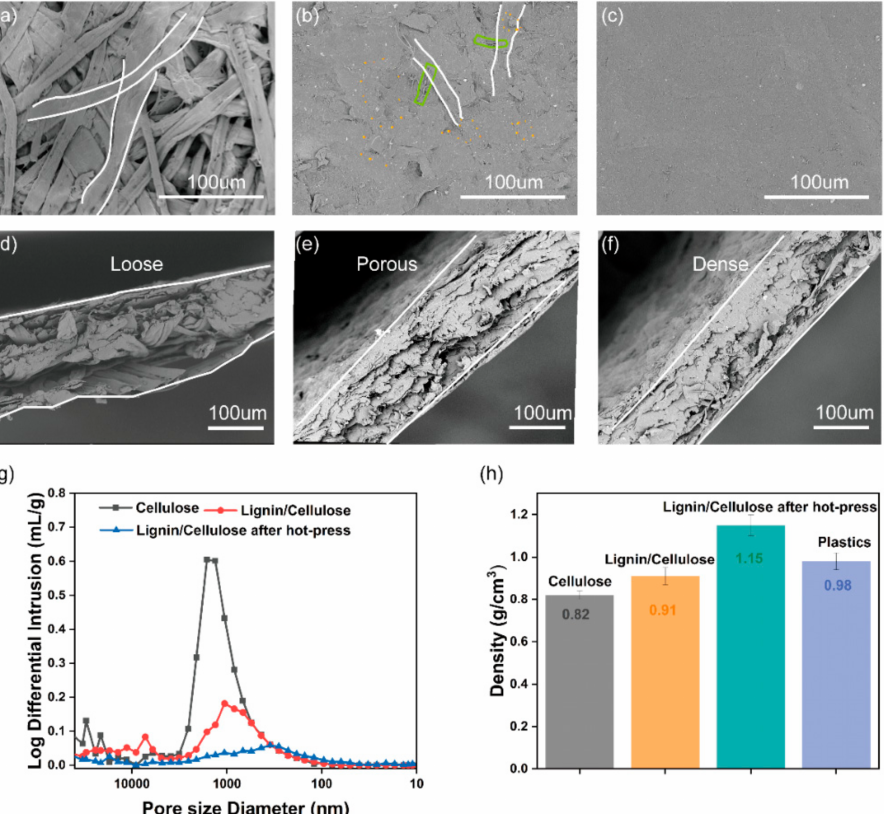
Figure 3. ( a – c ) Top view and ( d – f ) cross-section of the SEM diagram of the sheets of cellulose, lignin–cellulose, and lignin–cellulose after the hot-press treatment, respectively; ( h ) log differential intrusion image of the sheets; ( g ) density of the